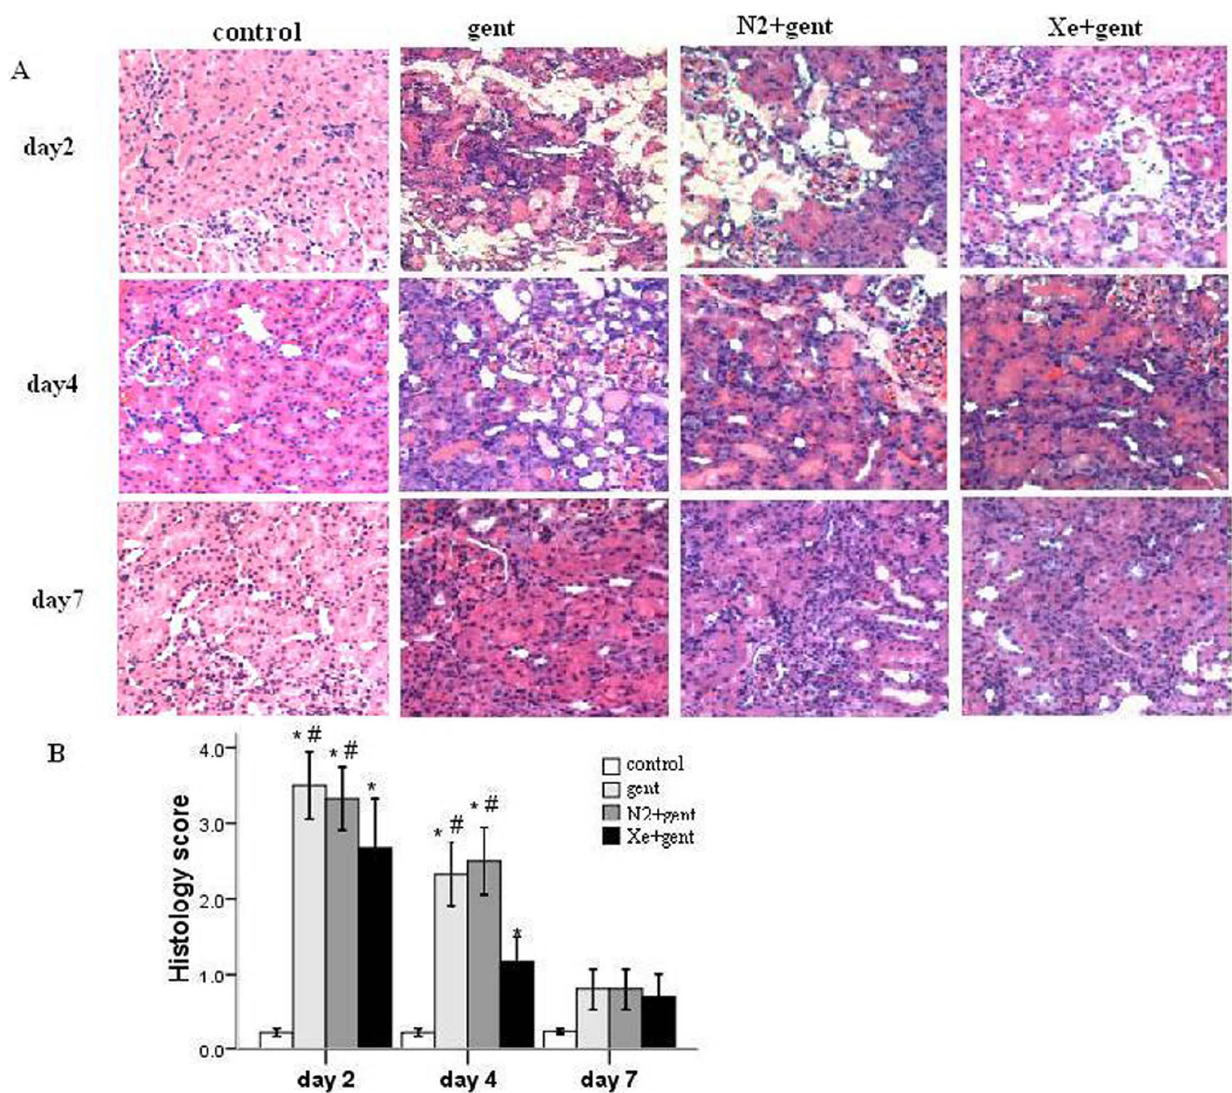
Figure 2. Effect of xenon on renal morphology. A: representative images of the cortex of renal sections from all groups 2, 4 and 7 days after 7- day gentamicin or saline injection respectively. (hematoxylin-eosin staining, 100 6 ).B: renal tubular injury assessed by histology grading scores in all groups. Xenon treatment significantly attenuated the renal tubular injury 2 and 4 days after 7-day gentamicin injection compared with the gentamicin group and N 2 + gentamicin group. *P , 0.01 vs control group; # P , 0.05 vs. Xe + gentamicin group, n=6/group at each time